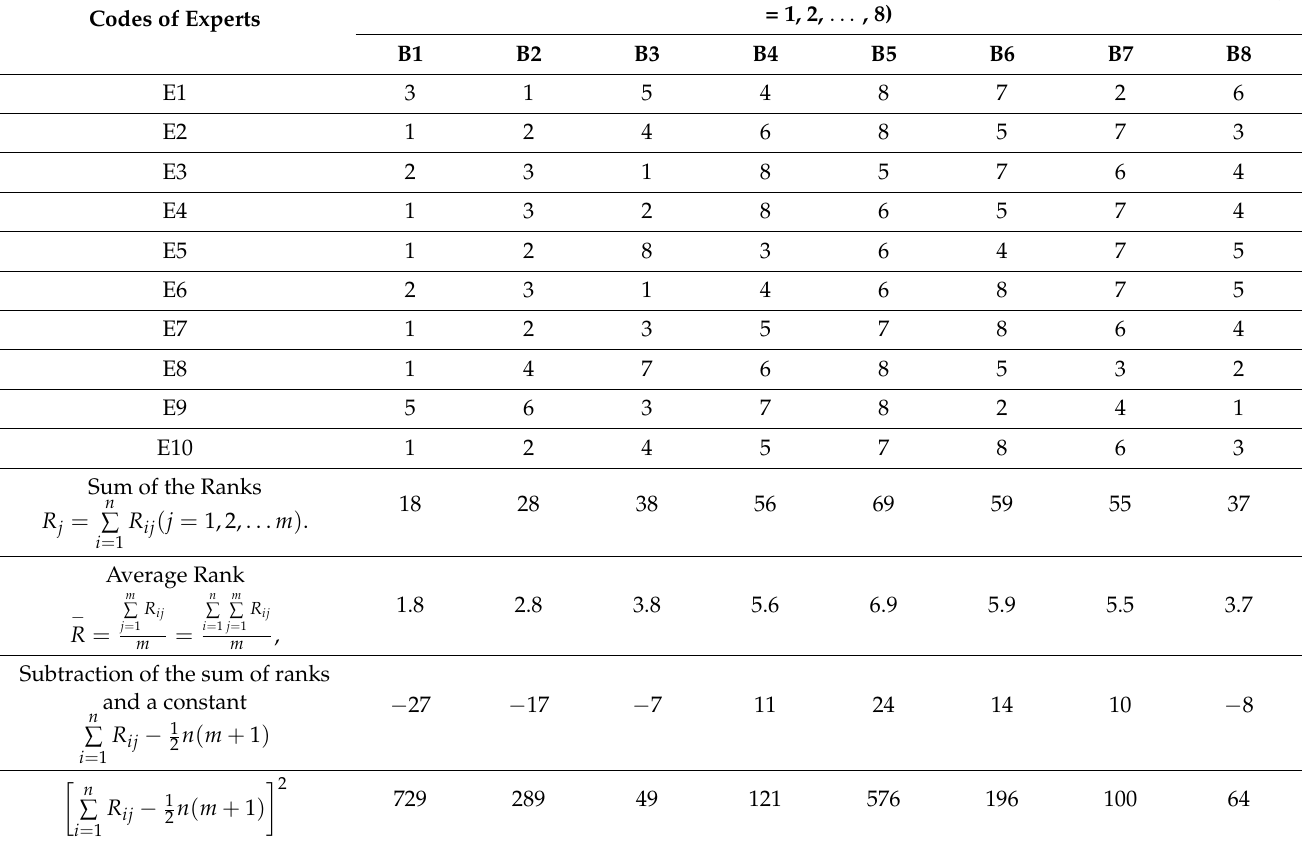
Table 4. Calculations of factors that have the greatest influence on the optimization of a city’s logistics